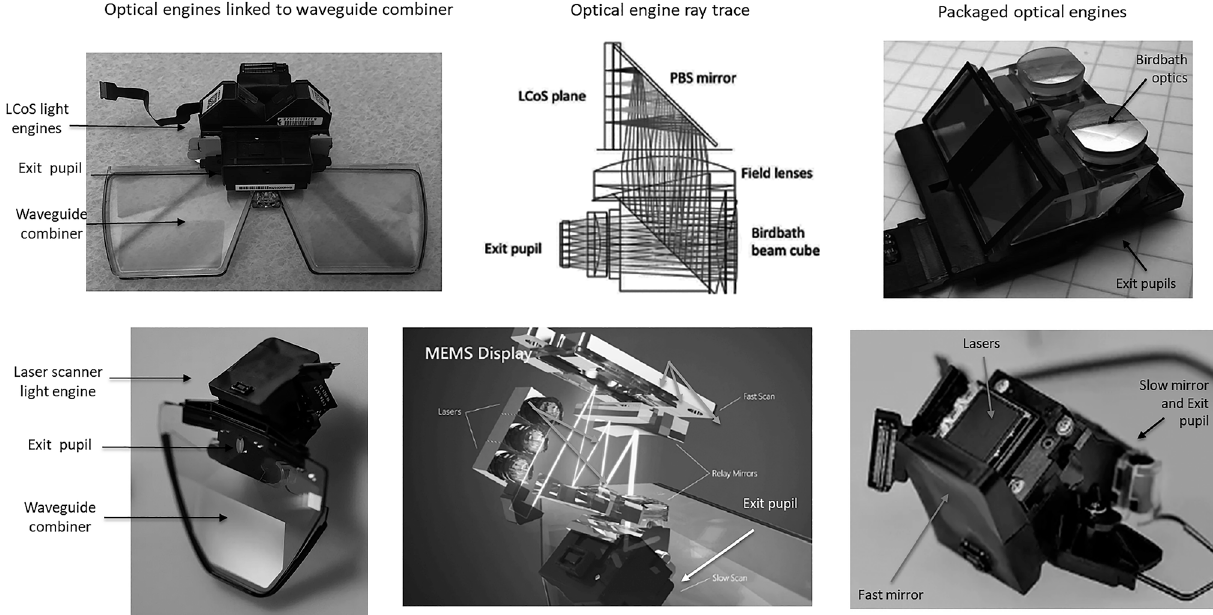
Figure4: DisplayenginesbasedonanLCoSimager,asintheHoloLens1(top,2016),andalaserMEMSscanner,asintheHoloLens2(bottom,